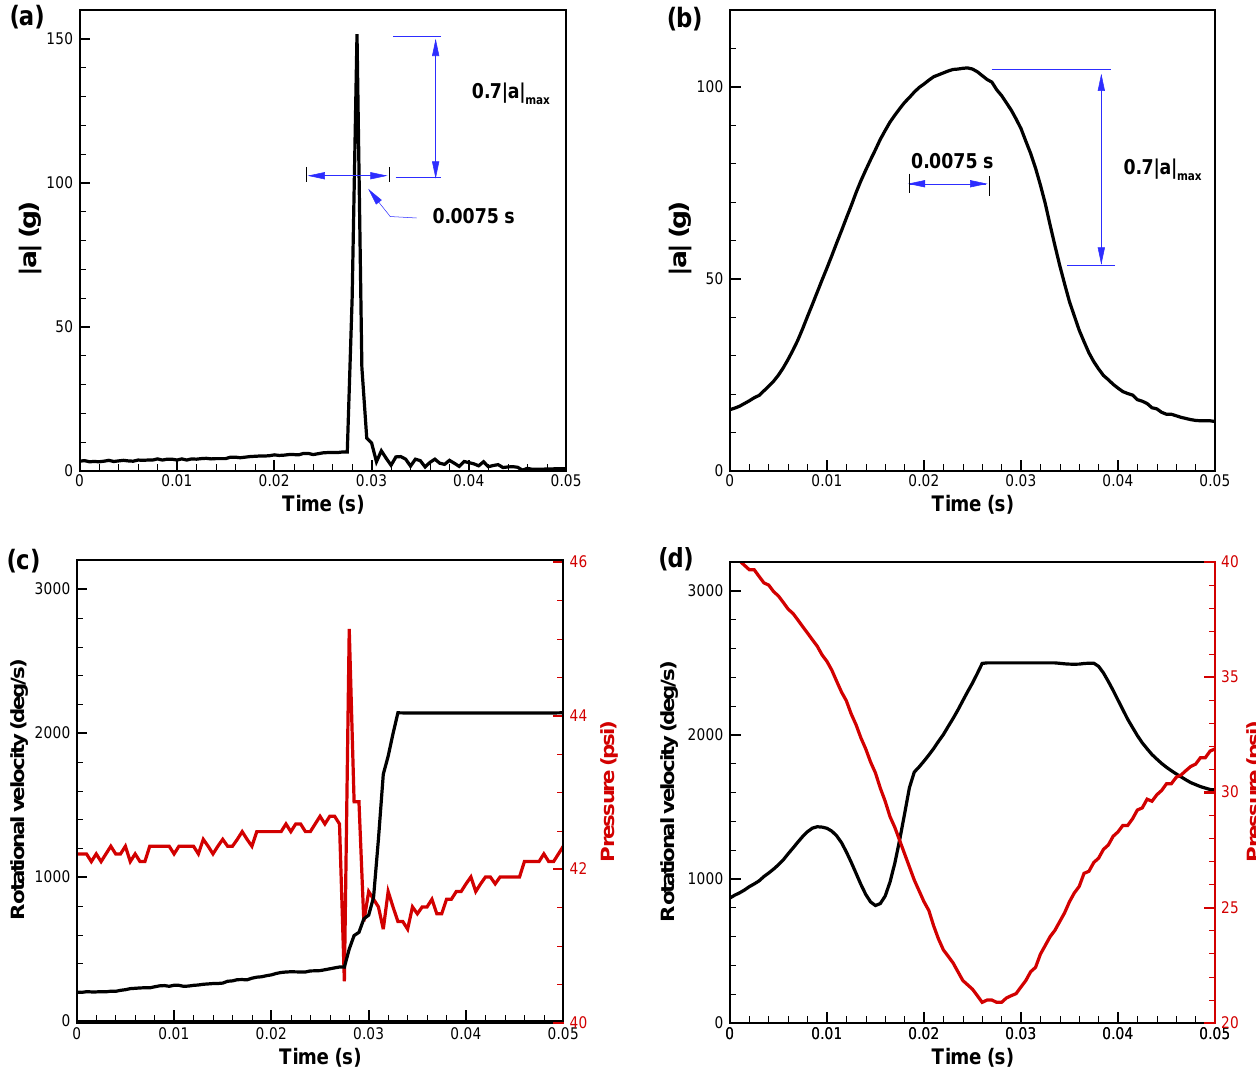
Figure 11 . Duration of acceleration within 70% of the peak value is (a) less than 0.0075 second for a collision event; (b) longer than 0.0075 second for a shear event. Pressure and rotation increase more dramatically during (c) a collision event than during (d) a shear